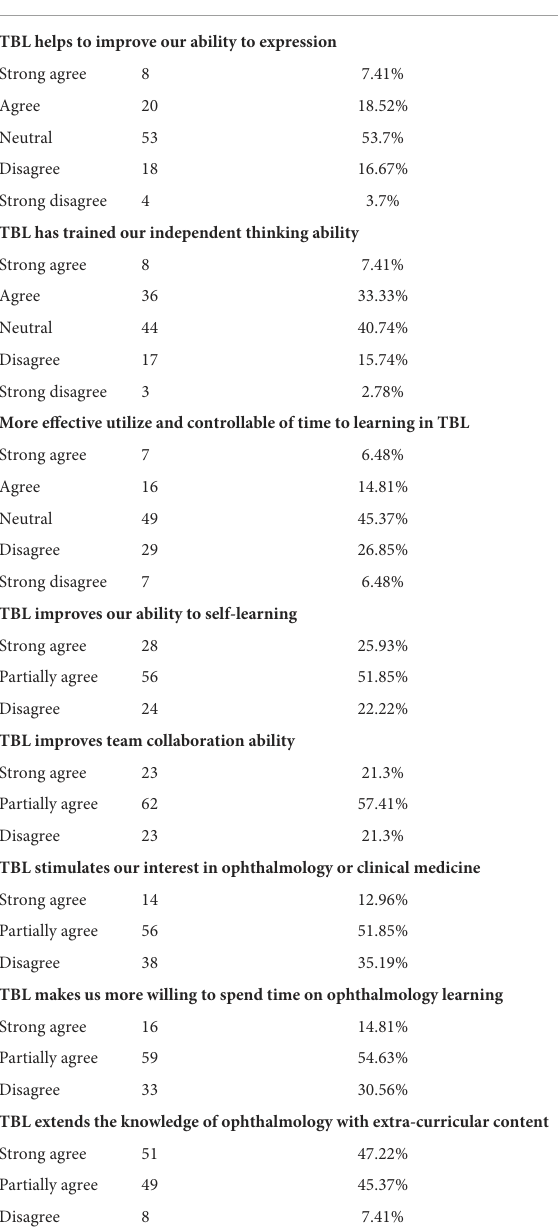
TABLE 2 Learning ability and